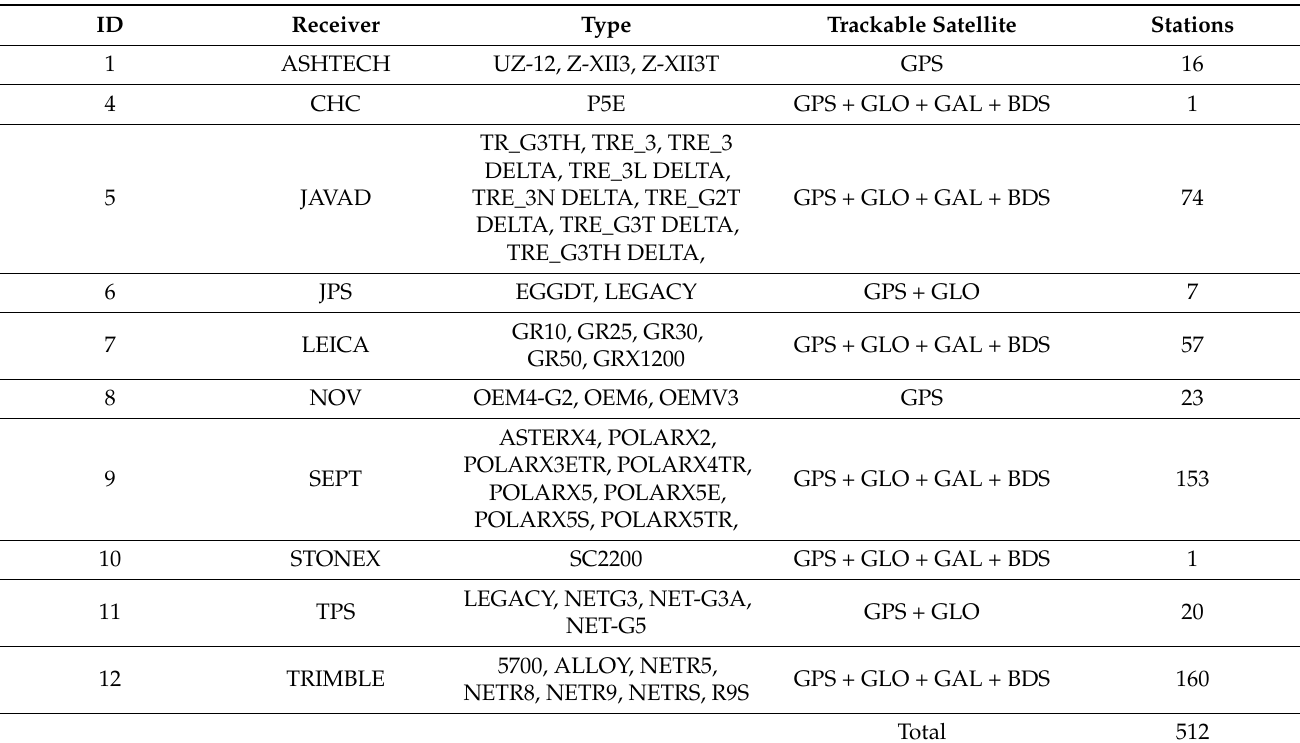
Figure 2. IGS/MGEX stations in May 2022. Table 3. Information of GNSS receiver in MGEX (until May